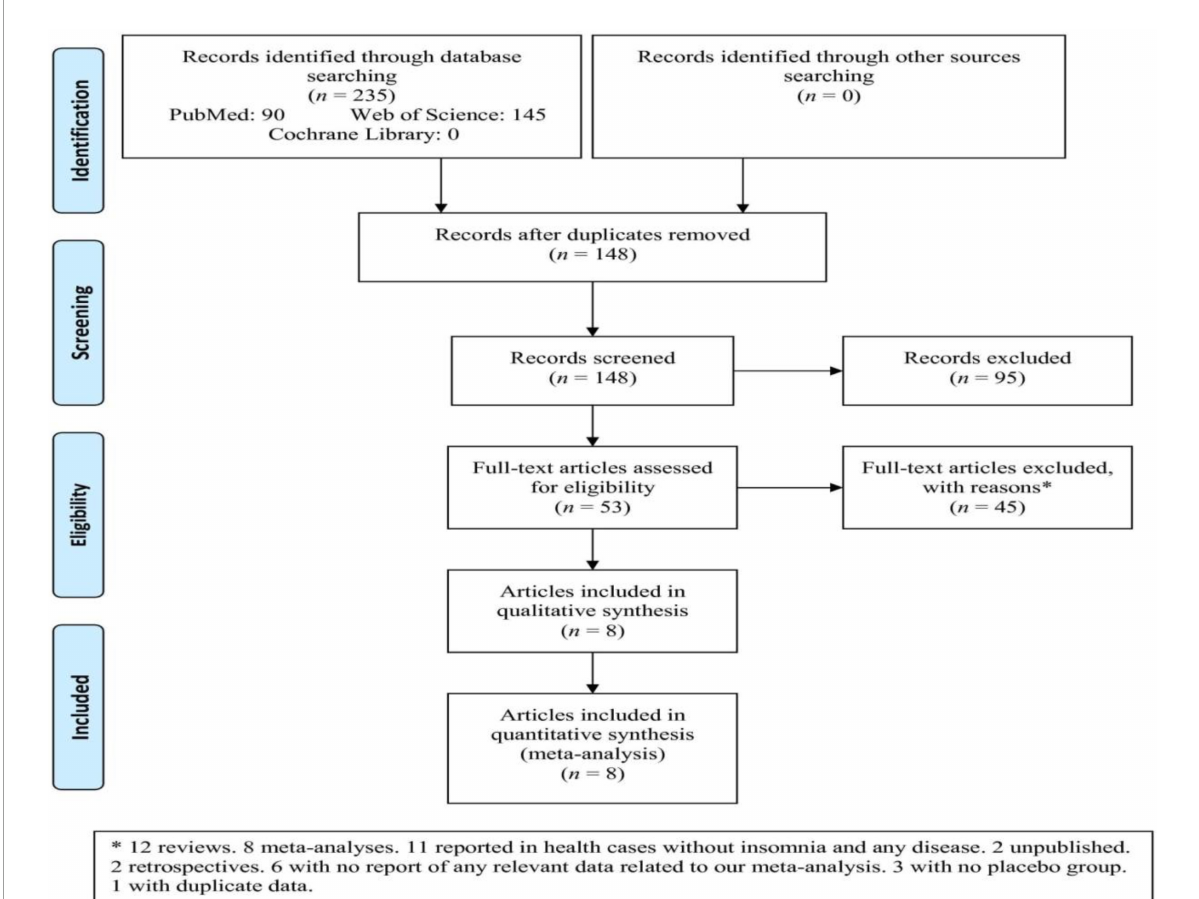
FIGURE1 Flowchart of the study selection. *Twelve reviews. Eight meta-analyses. Eleven reported in health cases without insomnia and any disease. Two unpublished. Two retrospectives. Six with no report of any relevant data related to our meta-analysis. Three with no placebo group. One with duplicate data.